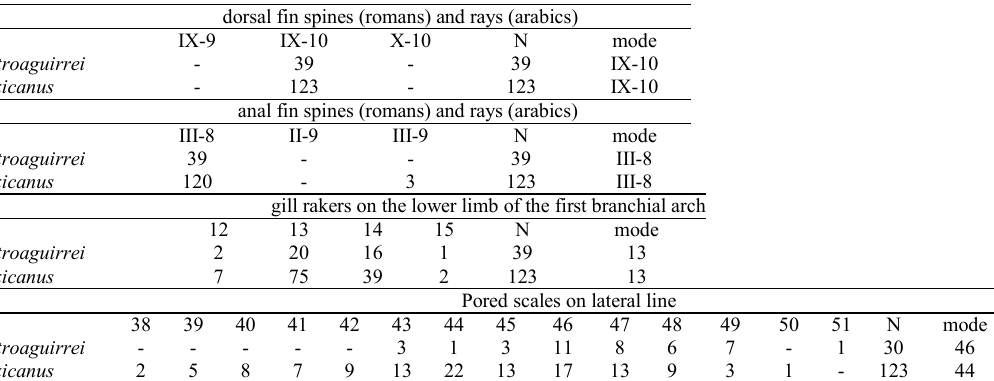
Table 4. Frequency distribution of meristic features of Eugerres castroaguirrei and E. mexicanus from the Grijalva-Usumacinta River Basin.